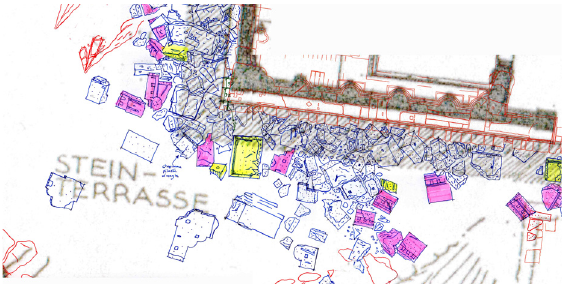
Figure 7. Sketches of scattered blocks.